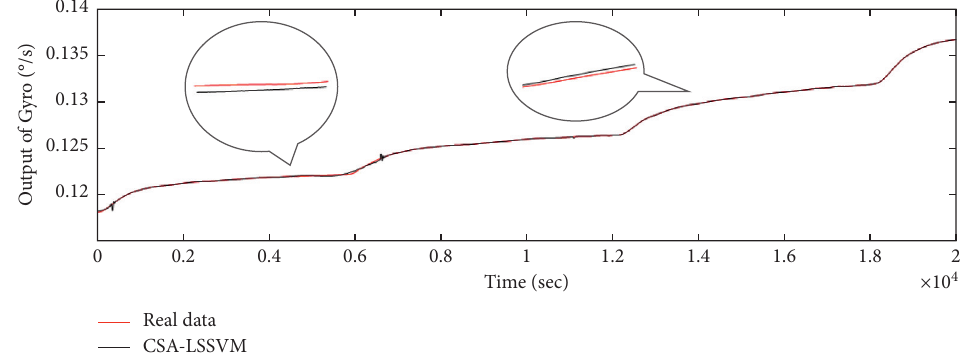
Figure 14: The result of CSA-LSSVM.